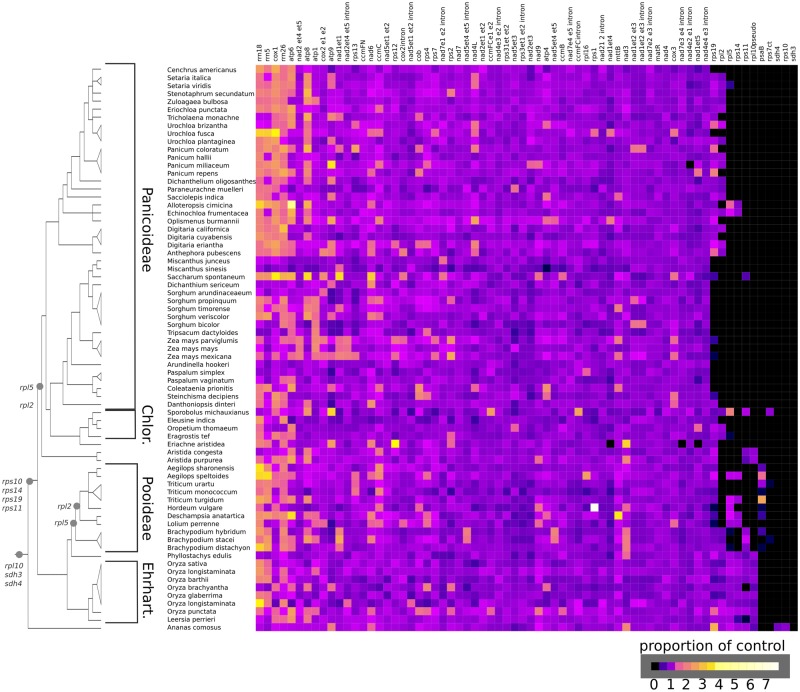
—Read depth-based heat map showing the variable intensity or lack of mt gene signature in Poaceae and A. comosus SRA readsets. Phylogenetic organization is taken from GPWG (2011). Functional transfer of genes to the nucleus indicated with gray dots: sdh3, sdh4 (Adams, Rosenblueth, et al. 2001), rpl10 (Mower and Bonen 2009; Adams et al. 2002; Kubo and Arimura 2010), rps10 (Adams et al. 2002), rps11 (Bergthorsson et al. 2004), rps14 (Sandoval et al. 2004; Ong and Palmer 2006), rps19 (Fallahi et al. 2005; Atluri et al. 2015), rpl2 (Subramanian and Bonen 2006), and rpl5 (Sandoval et al. 2004; Wu et al. 2017). The rpl2 transfer is placed in a deeper position in PACMAD clade than previously reported (Subramanian and Bonen 2006) based on the uniform absence of an intact orf in descending lineages (supplementary fig. 5, Supplementary Material online).